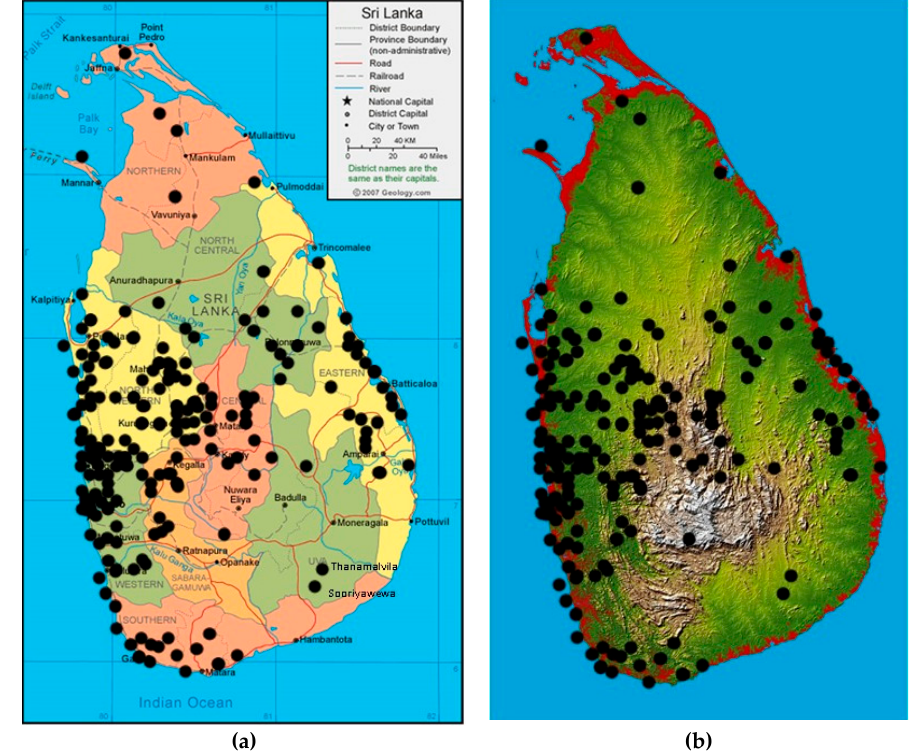
Figure 2. Geographical distribution of melioidosis cases in Sri Lanka. ( a ) By province. ( b ) By topography.